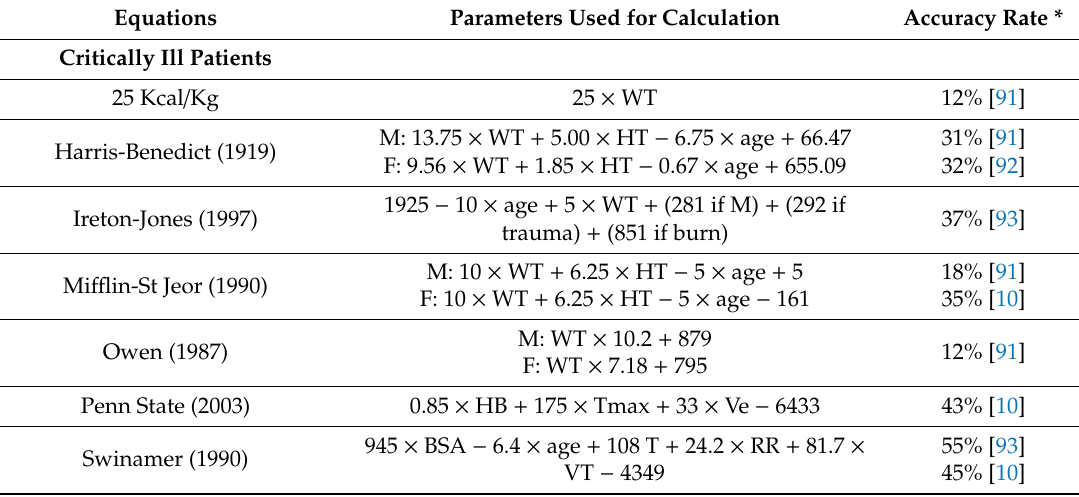
Table 4. Cont . Equations Parameters Used for Calculation Accuracy Rate * Critically Ill